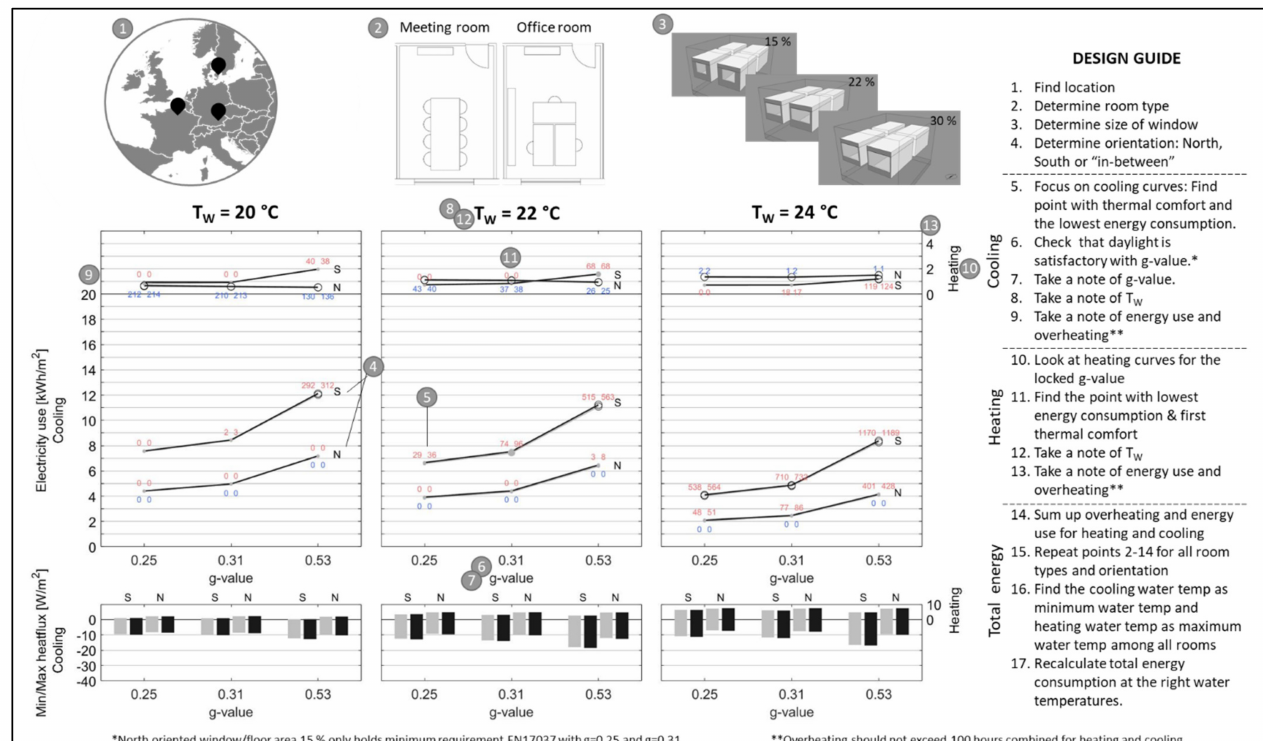
Figure 8. Diagram for feasibility guide for energy and